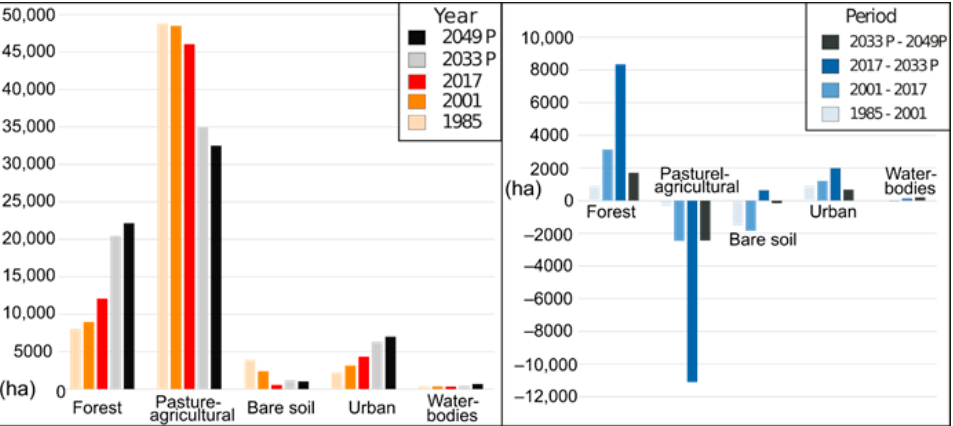
Figure 3. Distribution of the area occupied by LULC in the city of Temuco, 1985–2049. Source: Authors’ compilation. Note: P: Refers to simulated values. Authors’ compilation. Note: P: Refers to simulated